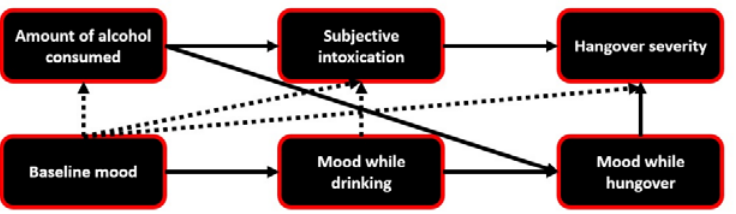
Figure 1. Associations between drinking variables, mood, and hangover severity. Lines represent significantly contributing variables to the regression analyses. Dashed lines connect variables that contributed less than 5% to the associations. The actual percentages are listed in Tables 3–6.